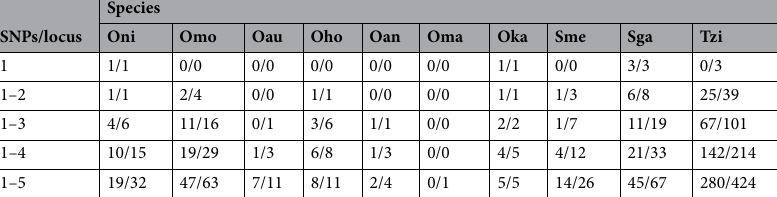
Sequence analysis.